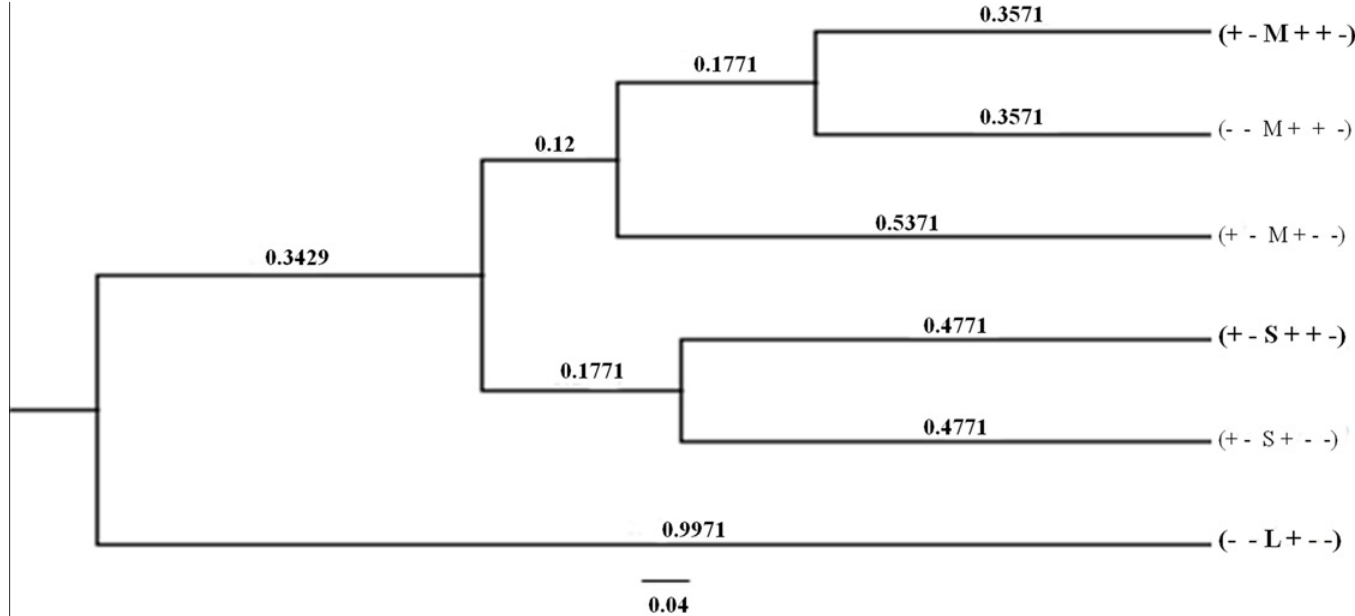
Fig 3. Phylogenetic tree of the Hb CS associated haplotypes constructed using the DendroUPGMA software applying Jaccard (Tanimoto) coefficient with default settings and 100 bootstrap replicates. Numbers indicate the branch lengths (divergence). Two major Asian Hb CS haplotypes; (+ — M + + -) and (+ — S + + -) and the predicted Mediterranean haplotype (- — L + — -) are indicated in bold face. The major haplotypes, (+ — M + + -) and (+ — S + + -), of Hb CS in Asian populations show common ancestors and are separated into each branch. In contrast, the Mediterranean haplotype represents clearly different